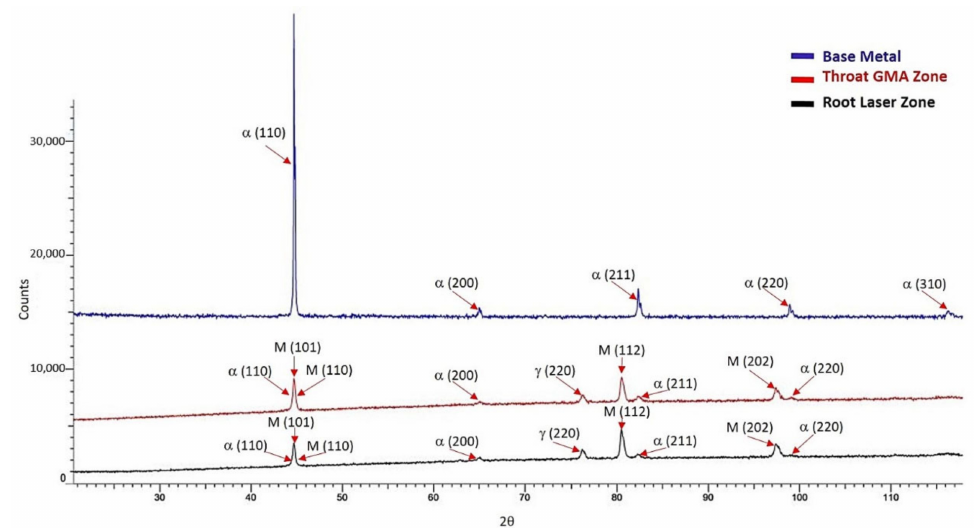
Figure 11. X-ray diffractograms, including phases identification, of base metal, root laser fusion zone, and throat arc fusion